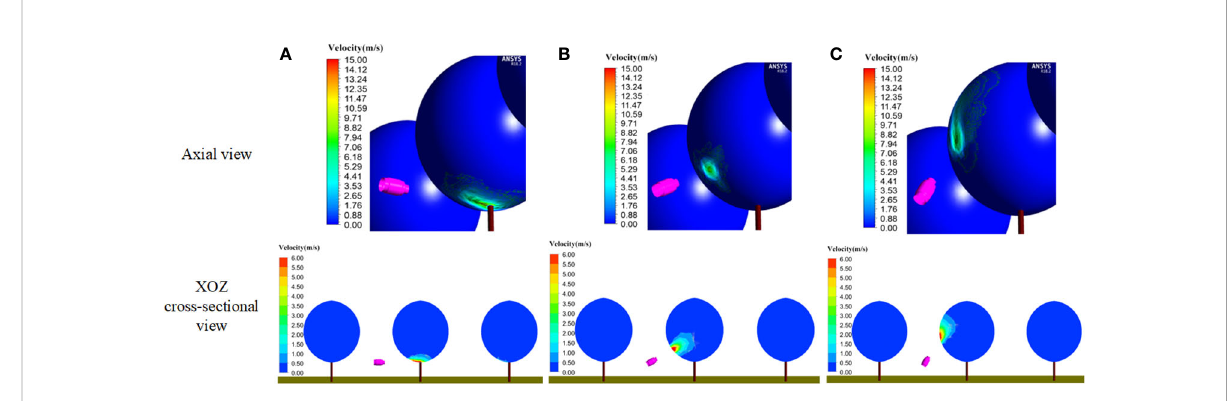
FIGURE 12 Fan air speed distribution under different swing-arm angles. (A) Swing-arm angle 0°. (B) Swing-arm angle 30°. (C) Swing-arm angle